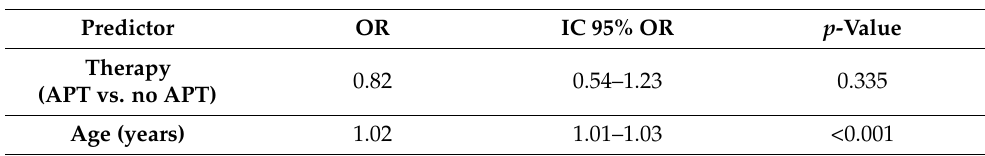
Table 3. Multivariate logistic models for bleeding risk. Logistic Model 4 (Multivariate Analysis)—Predictors: Therapy Adjusted for Age (Age Considered as a Continuous Variable)